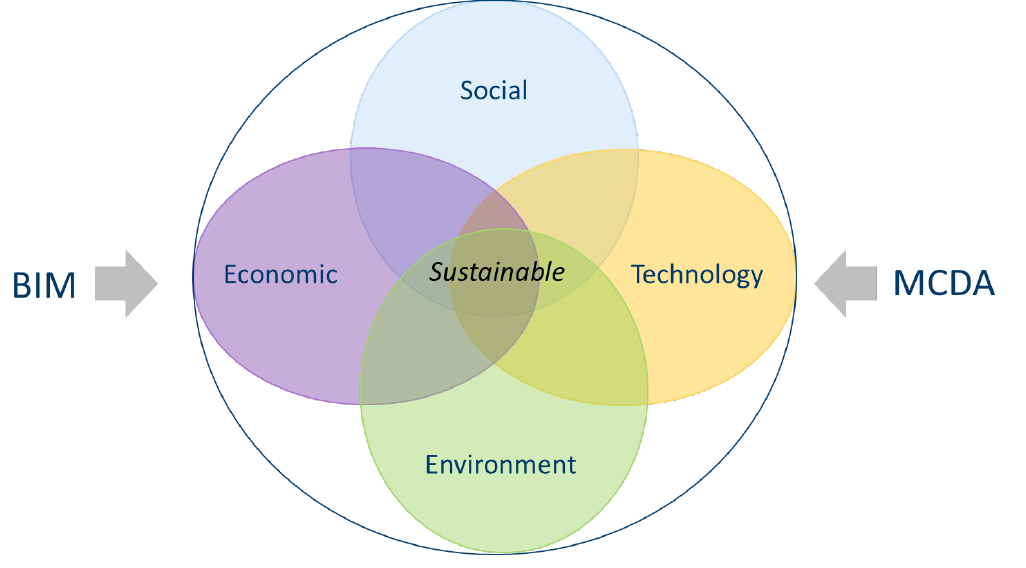
Figure 1. Sustainability categories used in research.